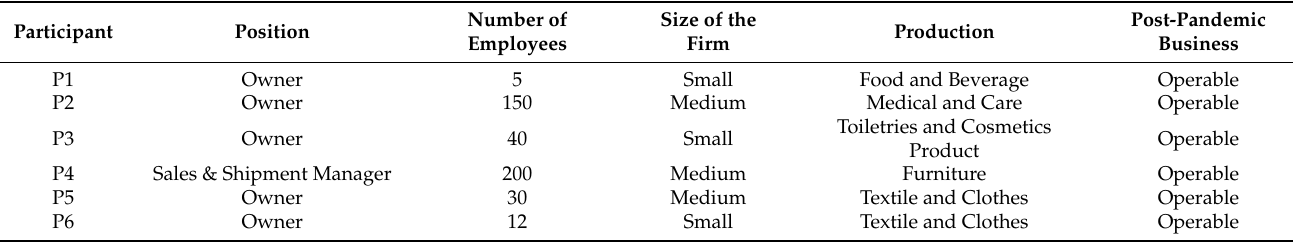
Table 1. Profile of participants from SMEs in the